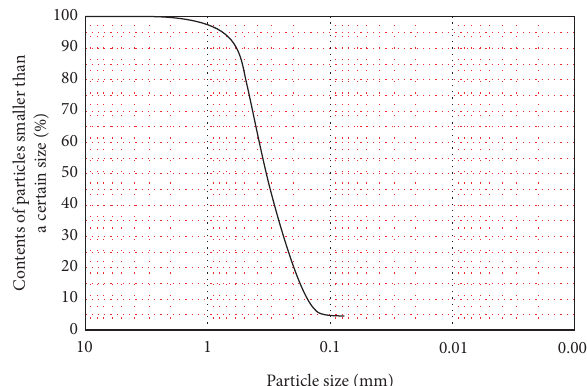
Figure 4: Grading curve of fine sand in